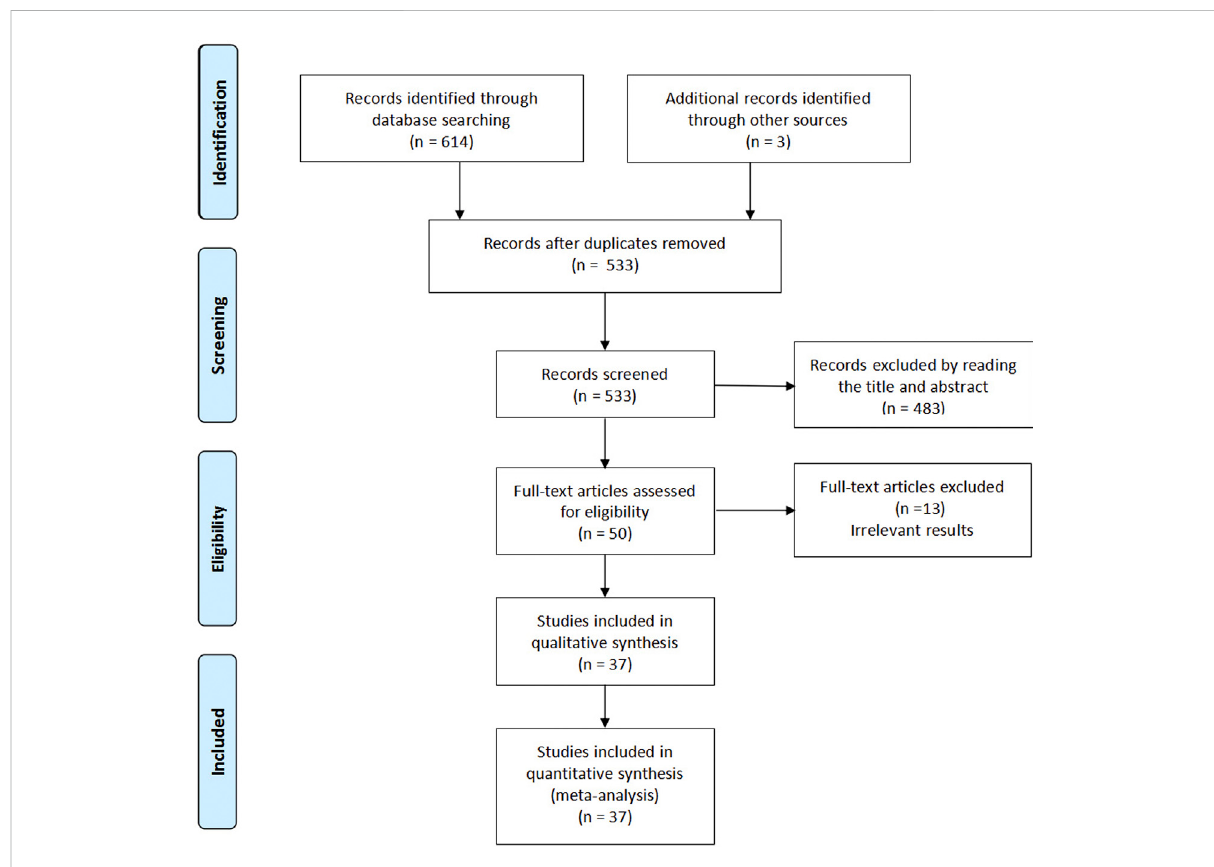
FIGURE 1 Flow chart for article selection in the